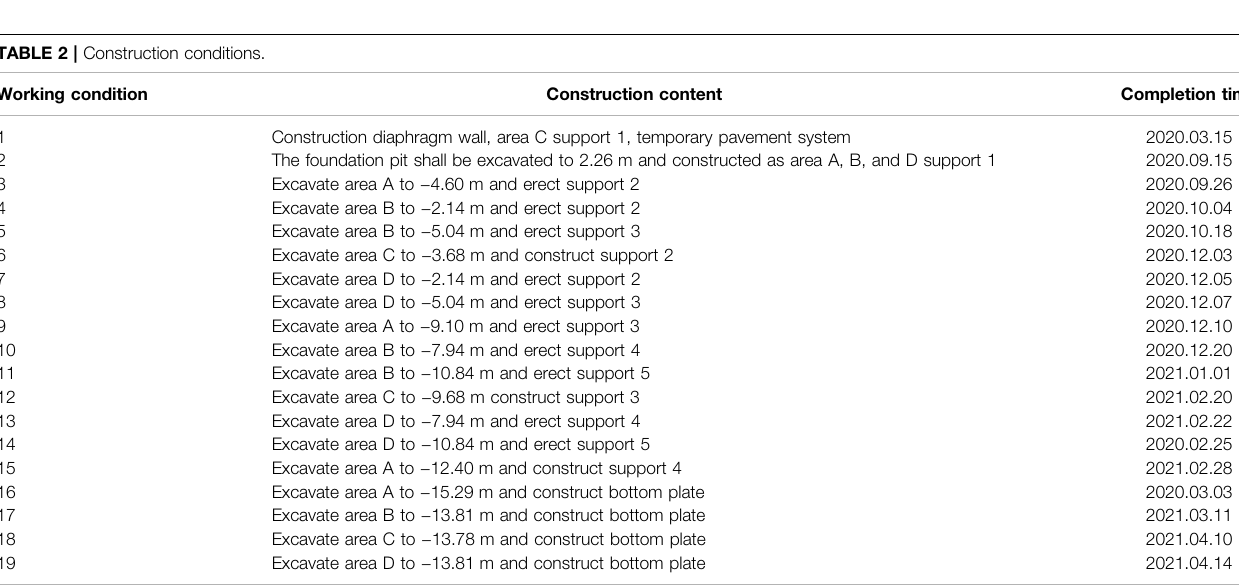
TABLE 2 | Construction conditions.